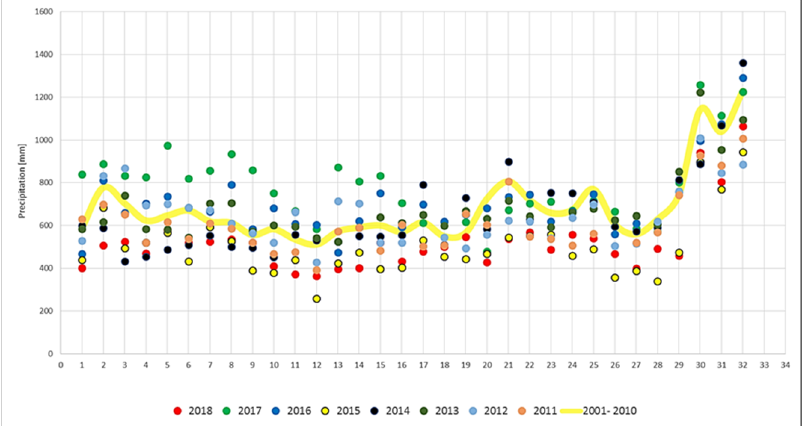
Figure 2. Rainfall distribution in Poland: annual precipitations for period 2011–2018 and the average rainfall for the decade 2001–2010 (data collected from 34 synoptic stations located throughout Poland); the numbers on the x axis represent the following stations: 1–4: Baltic Sea coastal region, 5–19: Polish Lowlands (a zone of lowlands in North and Central Poland), 20–27: Polish Highlands; 28–32: mountain areas (compiled on the basis of data published by the Central Statistical O ffi ce in the years 2001–2019